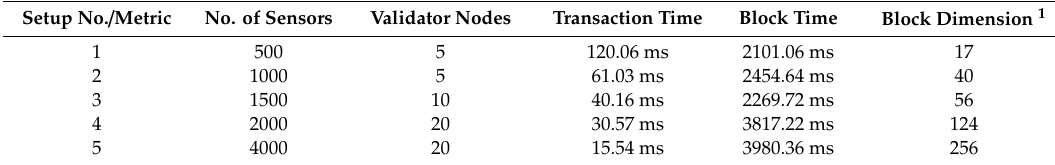
Table 2. Distributed Ledger Technology (DLT) metrics and the associated parameters. Setup No. /